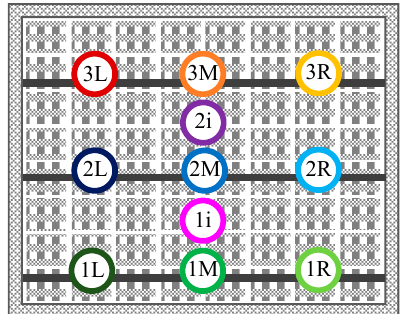
Figure 3. Position of DBT / RH sensors within the façade (positions for an observer inside the building).